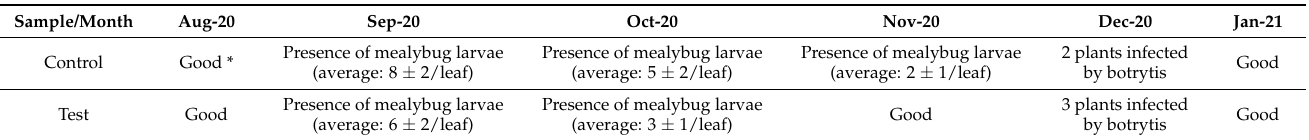
Table 1. Phytosanitary level per experimental piece sample per month.